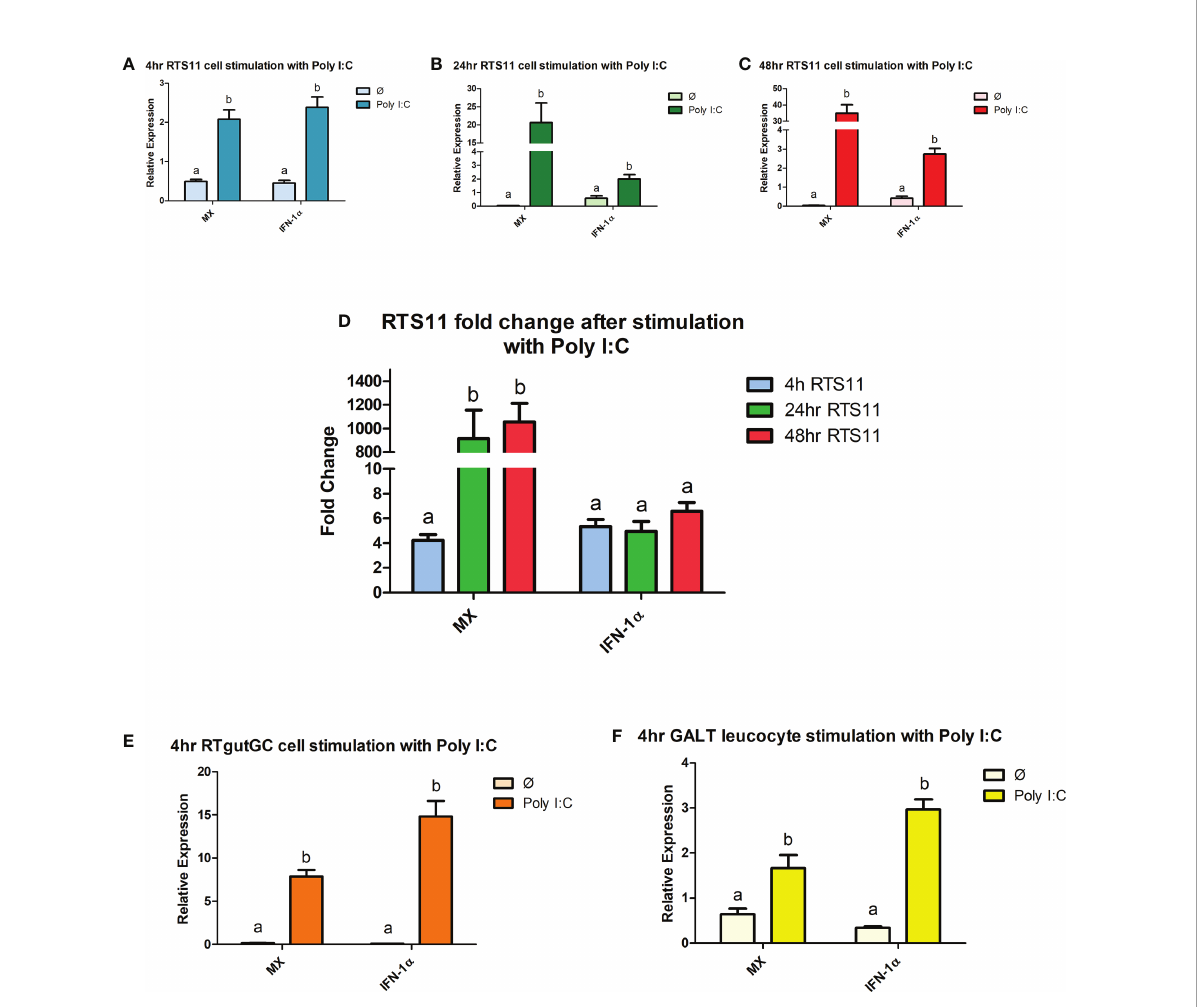
FIGURE 1 RTS11, RTgutGC and GALT leucocyte response to Poly IC. (A) RTS11 4hr Poly I:C stimulation showing relative expression. (B) RTS11 24hr Poly I:C stimulation showing relative expression. (C) RTS11 48hr Poly I:C stimulation showing relative expression. (D) RTS11 Fold Change between time points (4, 24 and 48 hr). (E) RTgutGC 4hr Poly I:C stimulation showing relative expression. (F) GALT leucocyte 4hr Poly I:C stimulation showing relative expression. For relative expression samples were compared between stimulated and unstimulated samples. a and b denote a signi fi cant difference where p <